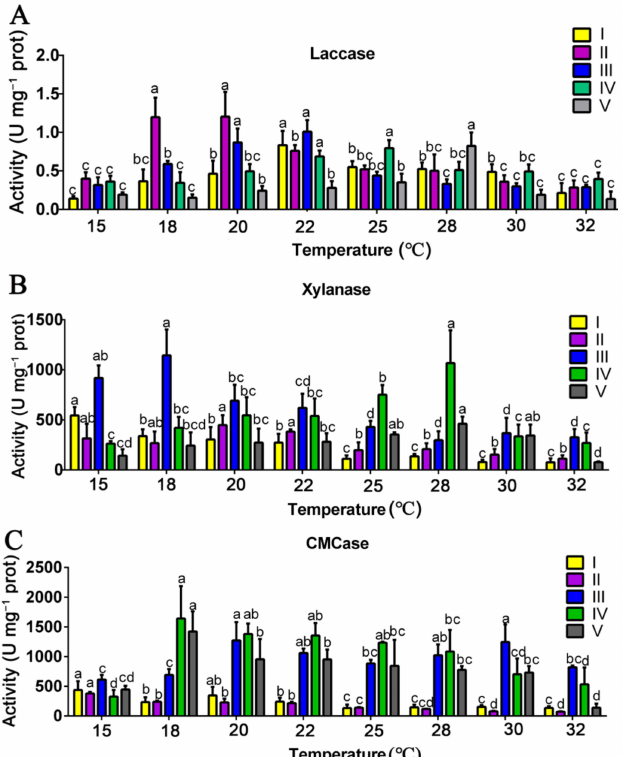
Figure 1. Effects of the mycelial culture temperature on the activities of lignocellulose-degrading enzymes. Activities of laccase ( A ), xylanase ( B ), and CMCase ( C ) at different mycelial culture temperatures at different growth and developmental stages of P. ostreatus . I, the stage of substrate half colonized by mycelia; II, the stage of substrate fully colonized by mycelia; III, the primordial; IV, the first harvest stage; V, the second harvest stage. The data are presented as the means from three independent measurements ± the standard deviations (indicated by the error bars). Different letters indicate significant differences between strains ( p < 0.05, as determined by Tukey’s